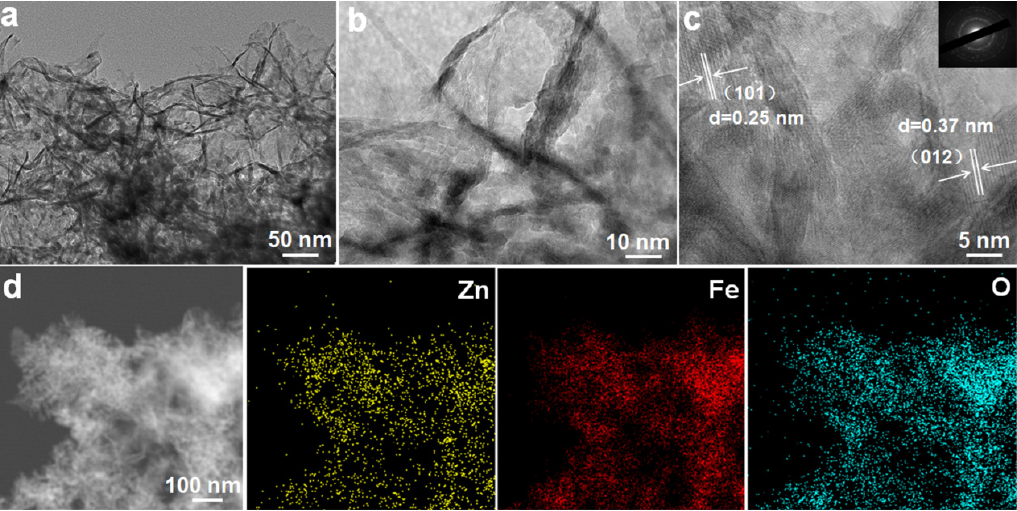
Figure 4. ( a , b ) TEM and ( c ) HRTEM images, SAED pattern (the inset in panel c), ( d ) STEM and corresponding elemental mapping images for the ZnO/Fe 2 O 3 NFs.